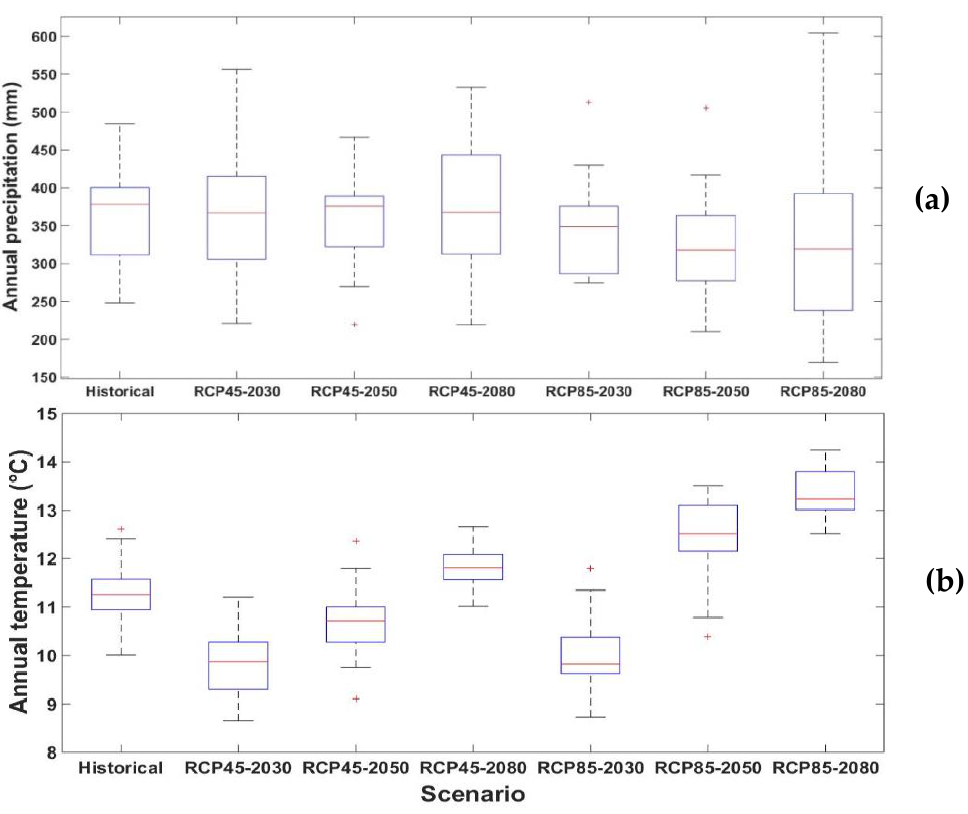
Figure 3. Box (whisker) plots of the predicted mean annual temperature ( a ) and precipitation ( b ) for the historical period (1987–2012) and the three future periods under the two RCPs.